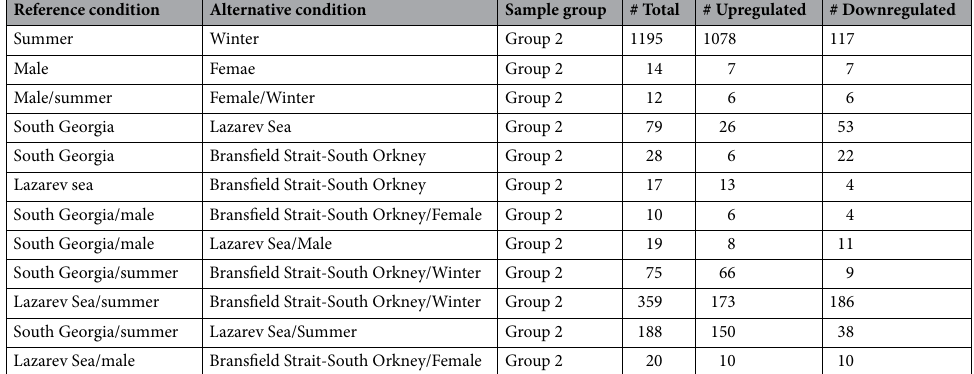
Table 4. List of contrasts computed with total number of differentially expressed genes and numbers of up- and downregulated